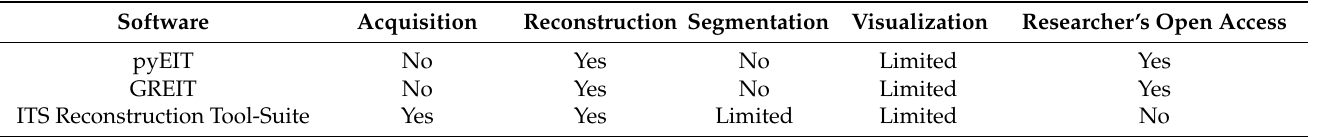
Table 1. Comparison of ERT software based on the availability of different